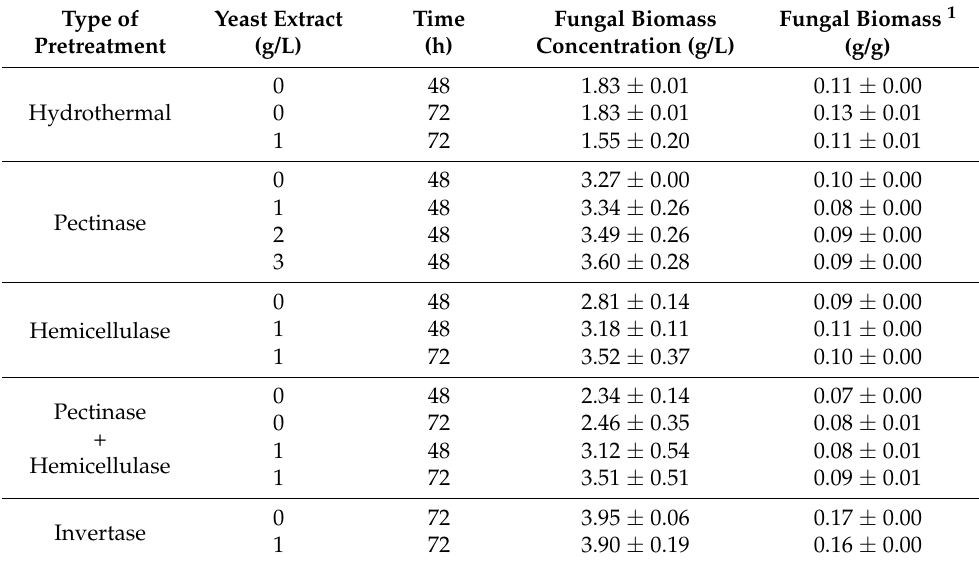
Figure 1. Process flow diagram for the valorization of carrot pomace. ( a ) The initial dry weight of CP was 800 g for all pretreatments. ( b ) Respective dry weight of the solid fraction after pectinase, hemicellulase, and invertase pretreatments of 660, 570, and 607 g. ( c ) The concentration of soluble solids (dry solid) in LFCP was 1.6, 2.9, 4.5, and 2.9 % after the hydrothermal, hemicellulase, pectinase, and invertase pretreatments, respectively. Table 3. Summary of the pretreatment and cultivation circumstances (shake flask